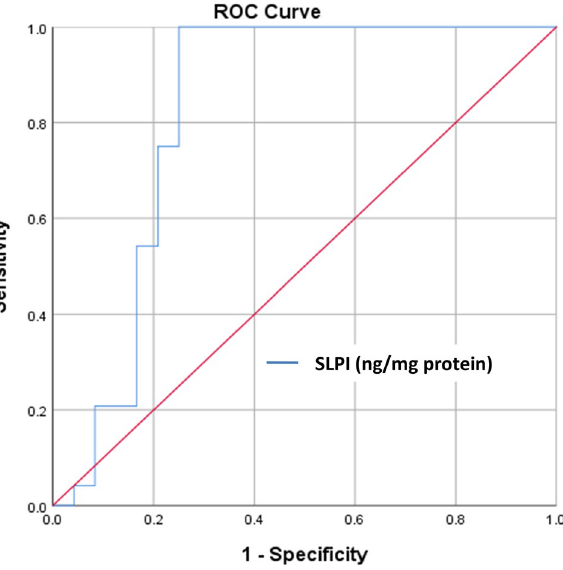
Figure 2. ROC curve for normalized salivary SLPI levels to identify periodontitis versus gingivitis. AUC: 0.82 with 100% sensitivity and 75% specificity (95% CI for the AUC: 0.68–0.96). ROC receiver operating characteristic, SLPI secretory leukocyte protease inhibitor, CI confidence interval, AUC area under the curve, ng nanogram, mg